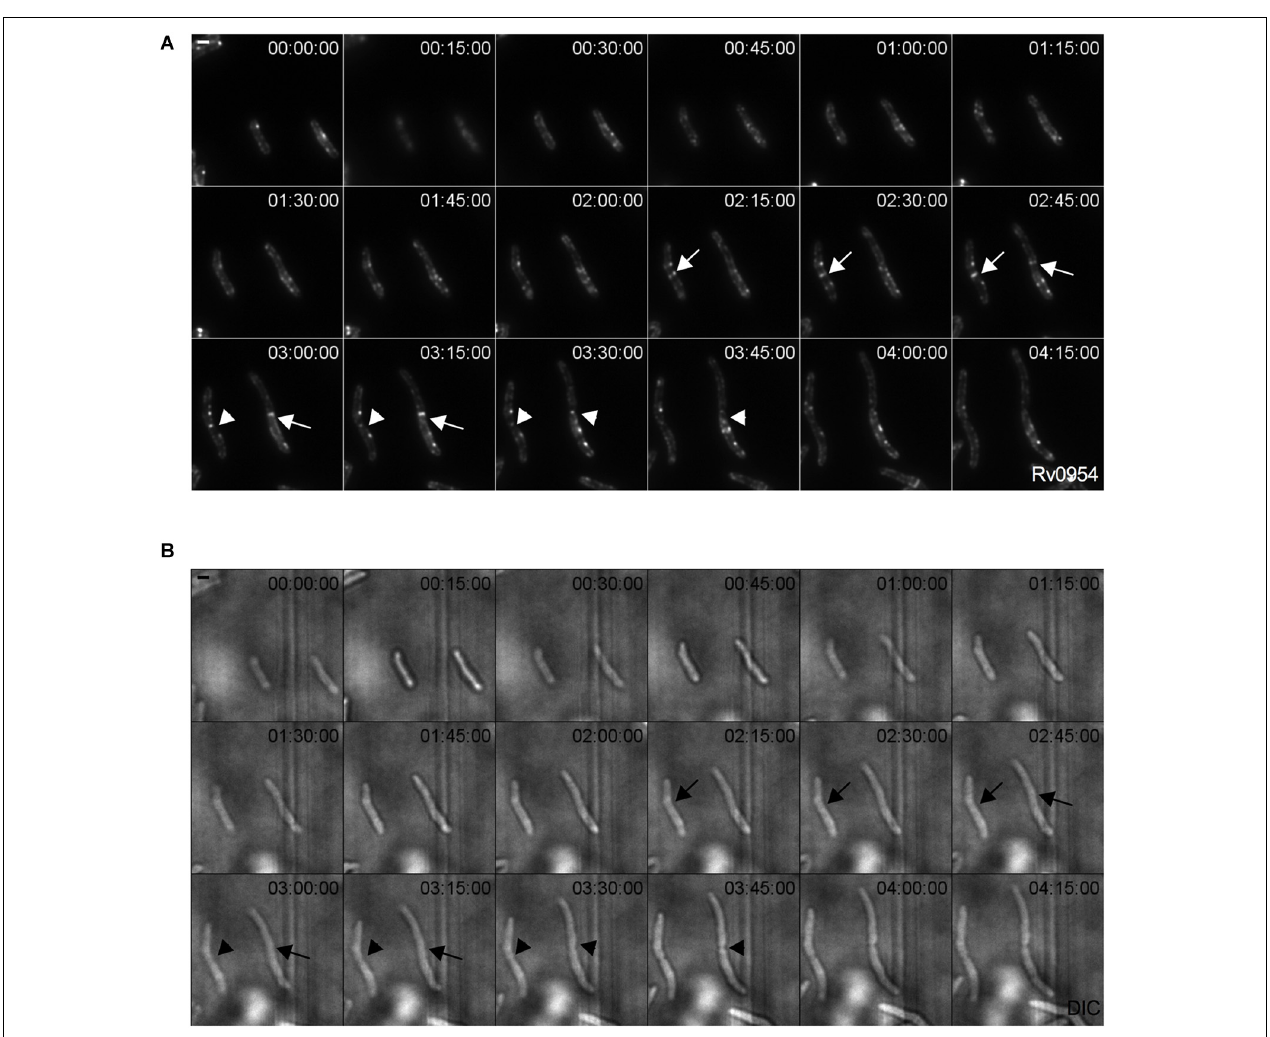
FIGURE 1 | Rv0954 localizes to the mid-cell during cell division. Representative image series from a time-lapse movie of replicating Msm that constitutively express Rv0954-GFP over 4 h and 15 min. Arrows point to mid-cell localization of Rv0954 before cell constriction, and arrowheads point to Rv0954 in cells undergoing constriction. Numbers in the upper right corner indicate time. Scale bar, 1 µ m. (A) GFP channel. (B) Transmitted-light snapshots.